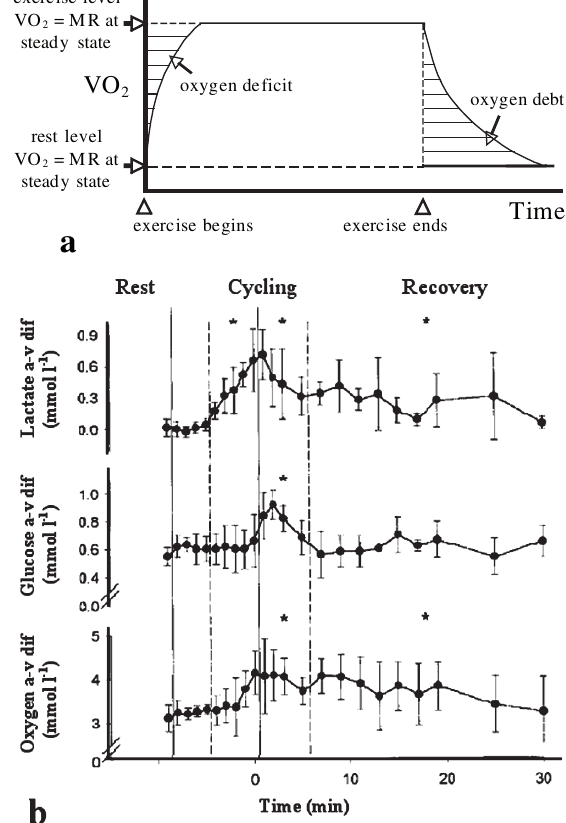
Fig . 1. – (a) schematic illustration of metabolic rate (Mr) and oxy- gen consumption (vo ) per unit time during an exercise-recovery 2 cycle. Mr is shown as a step function (dashed line), and vo fol- 2 lows Mr with some time lag (solid line). (b) each organ has analo- gous patterns in oxygen and nutrient a-v differences. Here we show oxygen, lactate, and glucose a-v differences in the human brain fol- lowing the onset of heavy exercise (dashed vertical line) and after its termination. adapted from Ide et al .